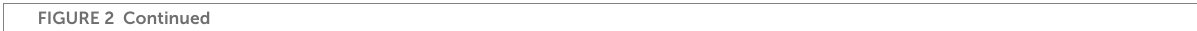
FIGURE 3 Synthetic type I IFN signaling inhibits Hyper-IL-6 induced proliferation of Ba/F3-gp130 cells. (A) Proliferation of Ba/F3- gp130, Ba/F3-gp130-V G mIFNAR1-V C mIFNAR2, and Ba/F3-gp130-